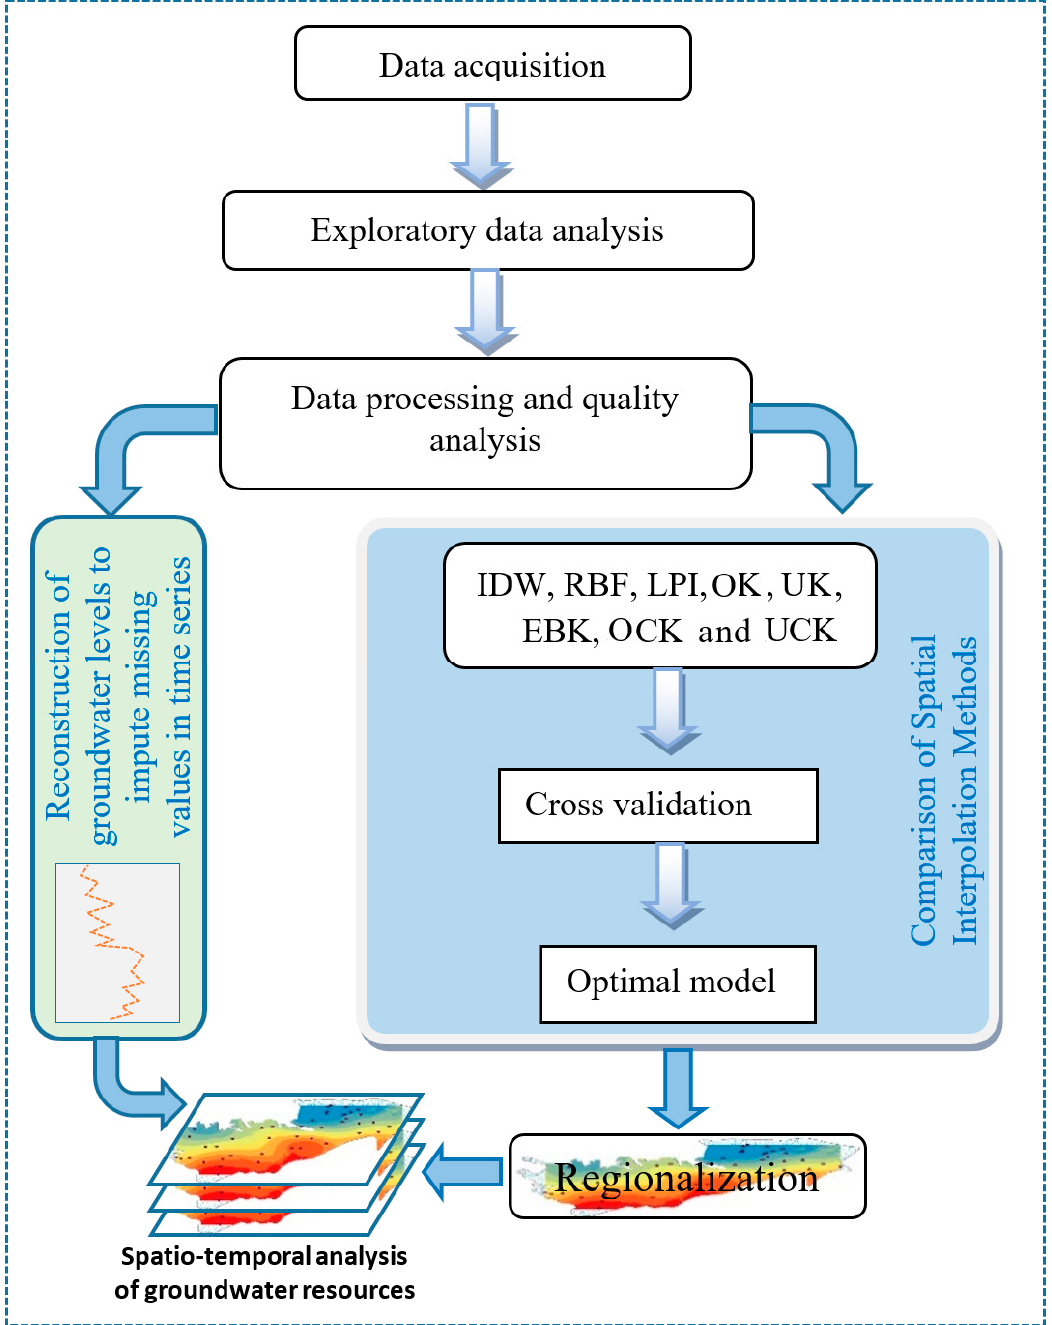
Figure 4. Methodology flowchart